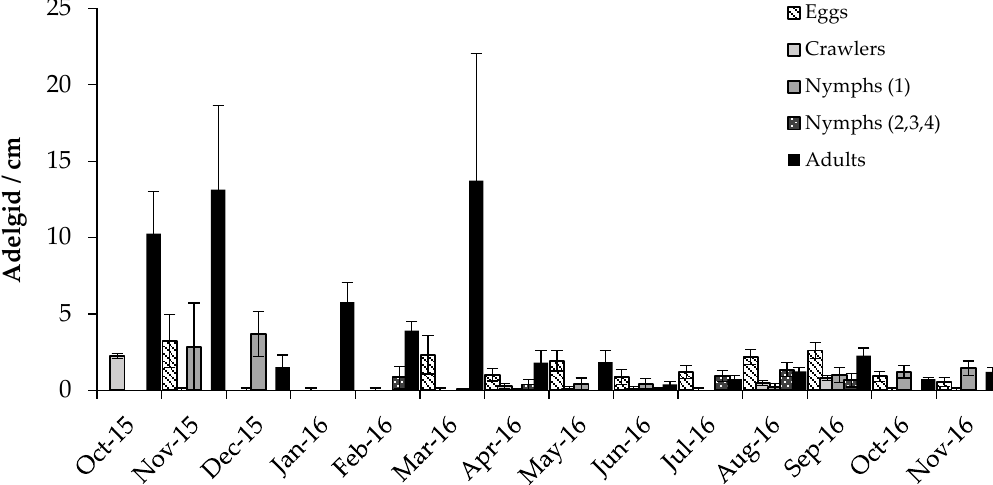
Figure 3. Mean number (±SE) of Pineus strobi by lifestage collected from Pinus monticola in Tacoma, WA, USA (October 2015 – November 2016).